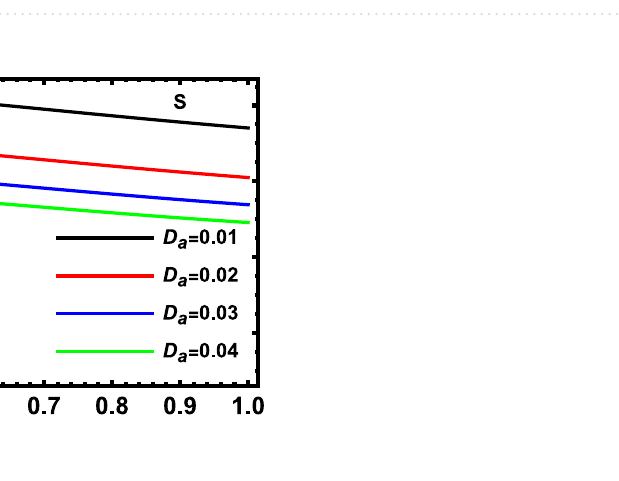
Figure 4. Displays the deviation of the growing amount against the wave numeral of numerous standards for the Weber Numeral W e .